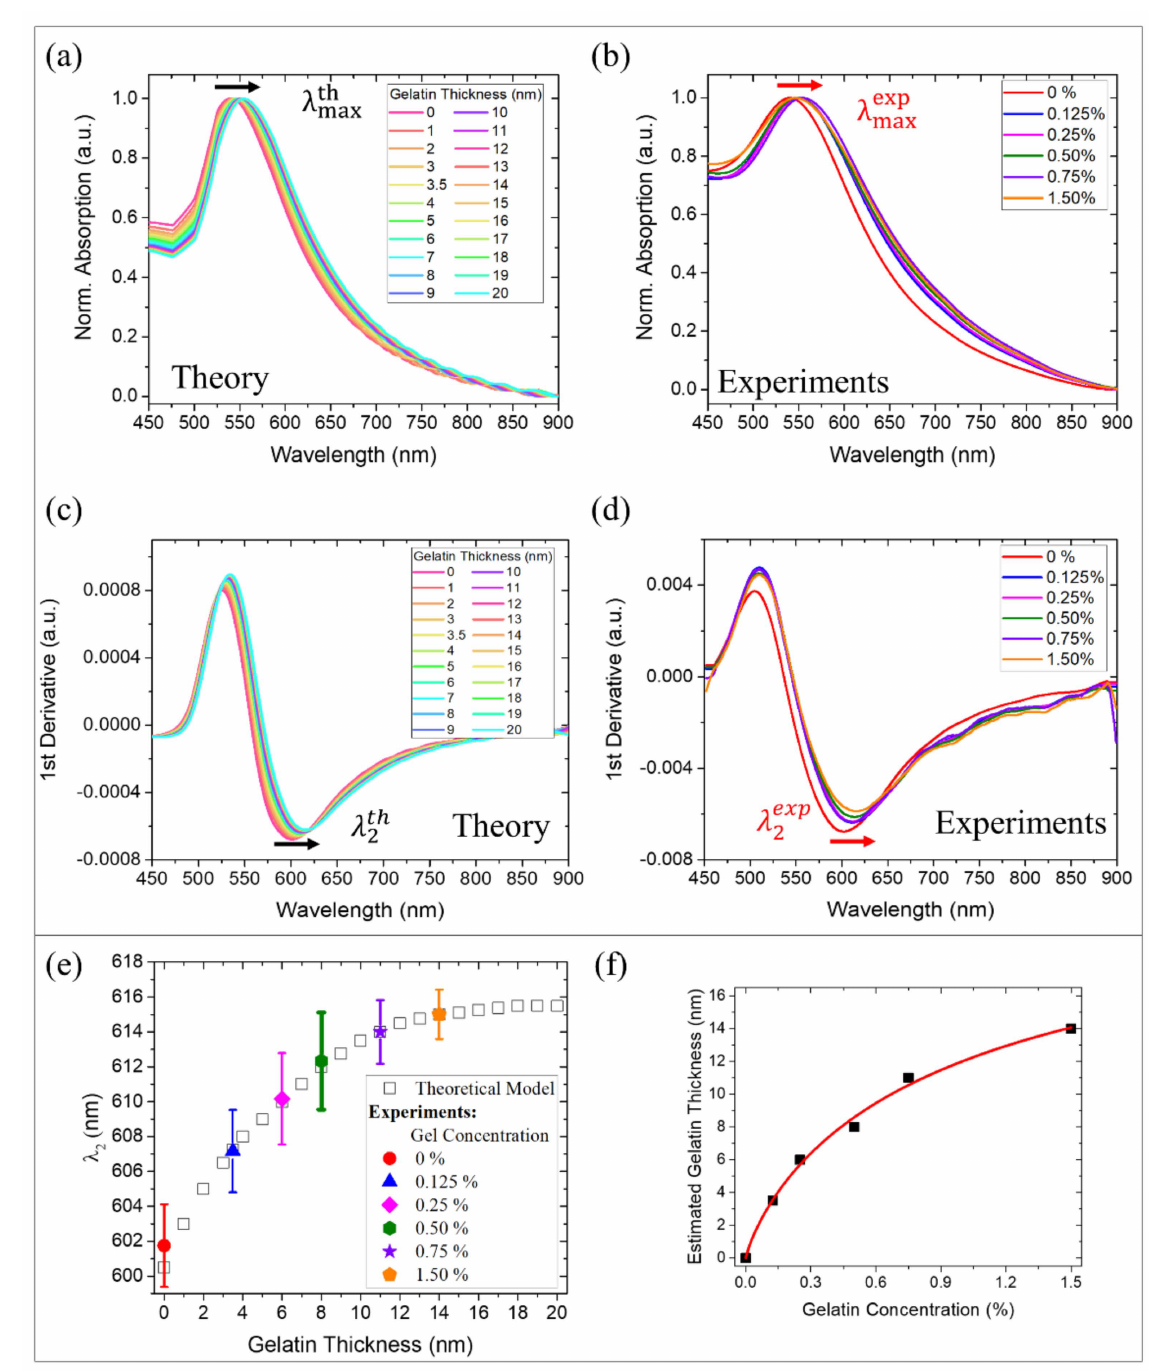
Figure 3. Correlation between gelatin concentration and thickness: ( a – c ) theoretical absorption spectra and first derivatives of AuDNPs with increasing gelatin shell thicknesses. The black arrows (redshifts of ( a ) λ th max and ( c ) λ th ) are associated with 2 the increase in the gelatin coating thickness. ( b – d ) Experimental absorption spectra and first derivatives of AuDNPs with increasing gelatin concentrations: 0% (red), 0.125% (blue), 0.25% (purple), 0.50% (green), 0.75% (violet), 1.50% (orange). The red arrows (redshifts of ( b ) λ exp max and ( d ) λ exp ) are associated with increasing gelatin concentrations. ( e ) Comparison 2 between λ th versus gelatin-coating thickness (theoretical model, white squares) and λ exp versus gelatin concentration 2 2 (experimental data, colored squares). ( f ) Correlation between the gelatin concentration and estimated coating thickness. The red line is a fitting of the scatter plot (Equation